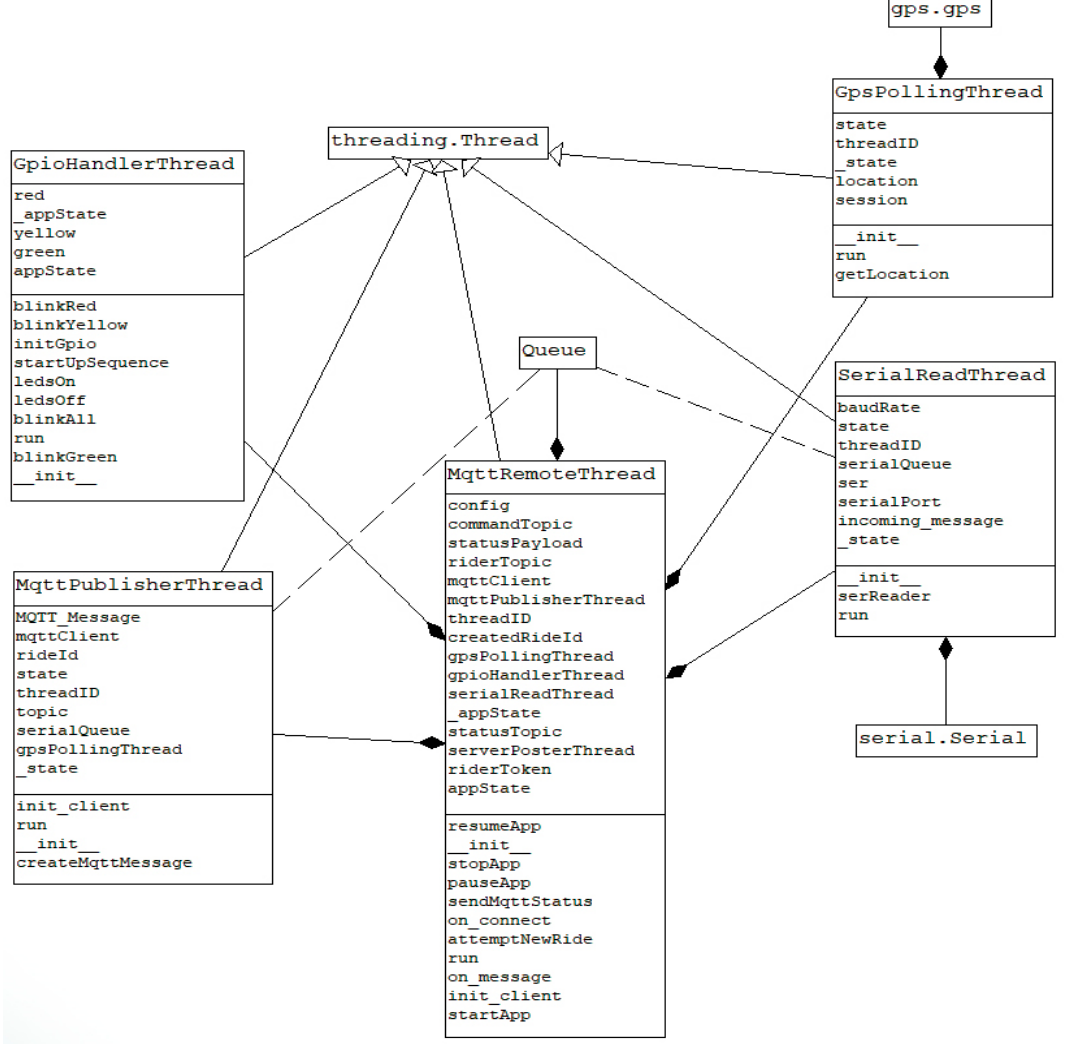
Figure 11. UML classes diagram.